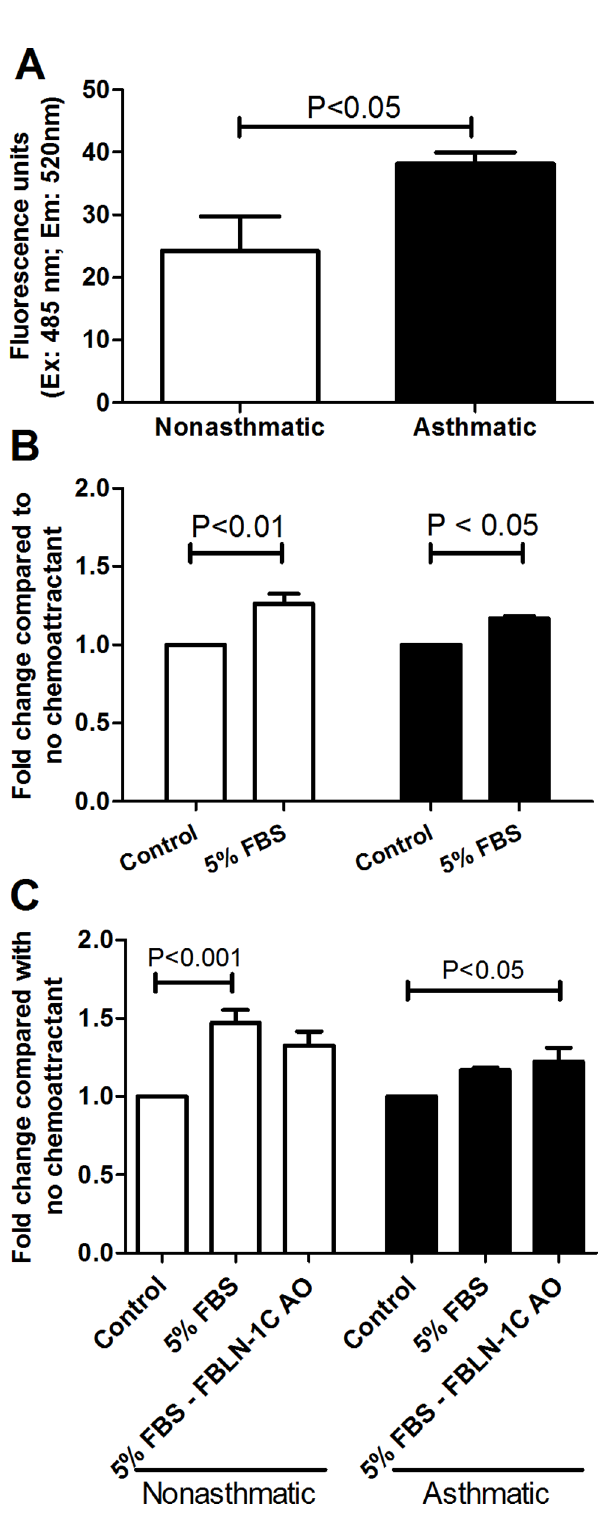
Figure 11. FBLN-1C does not alter migration of ASM cells. Migratory rates of non-asthmatic (white, n=4–5) and asthmatic (black, n=4–6) ASM reseeded on an ECM deposited by an asthmatic ASM cell line in the absence (A) or presence (B) of a chemoattractant (5% FBS). (C) ASM cells from non-asthmatic (n=4) or asthmatic (n=4–5) volunteers were reseededonto anasthmatic ECMin whichFBLN-1C was inhibited by a FBLN-1C specific AO and the effect on cell migration in response to 5% FBS was determined. Data are expressed as mean 6 SEM.